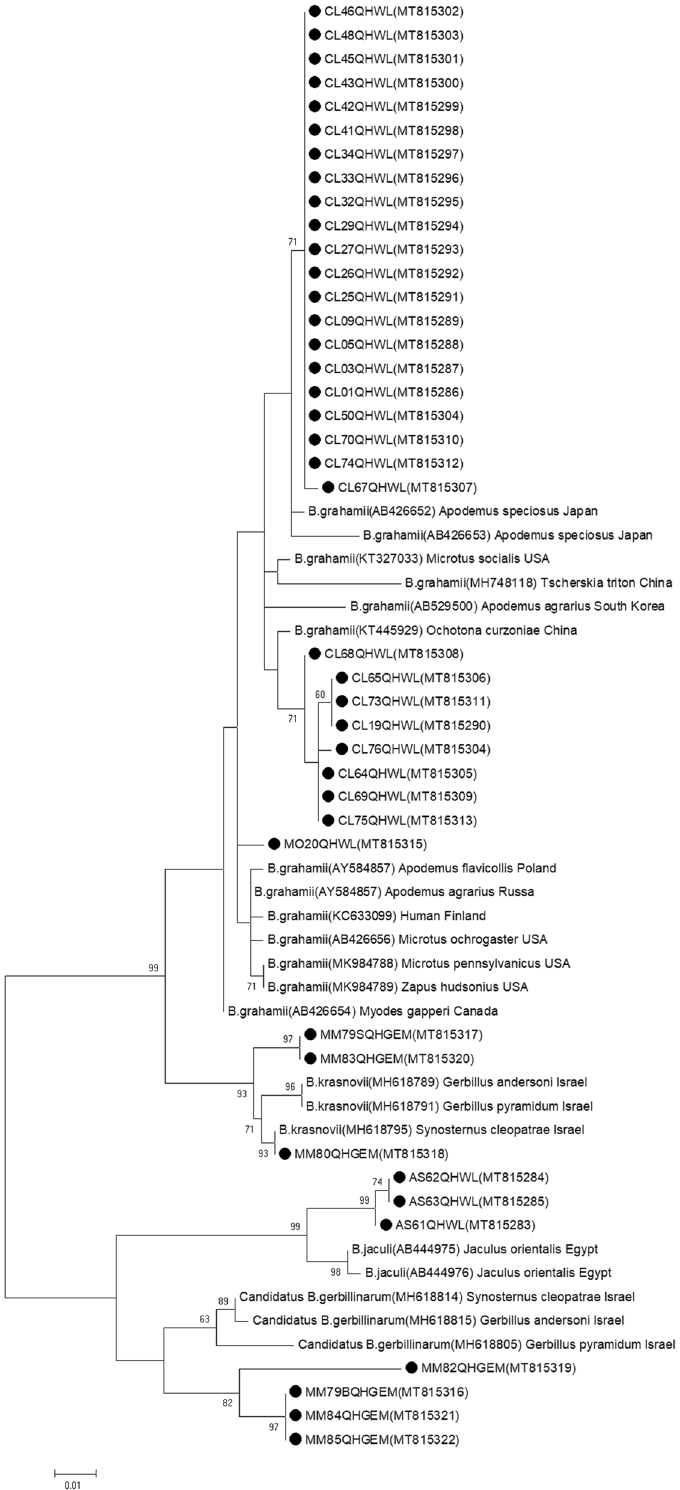
Figure 4. Phylogenetic analysis based on gltA